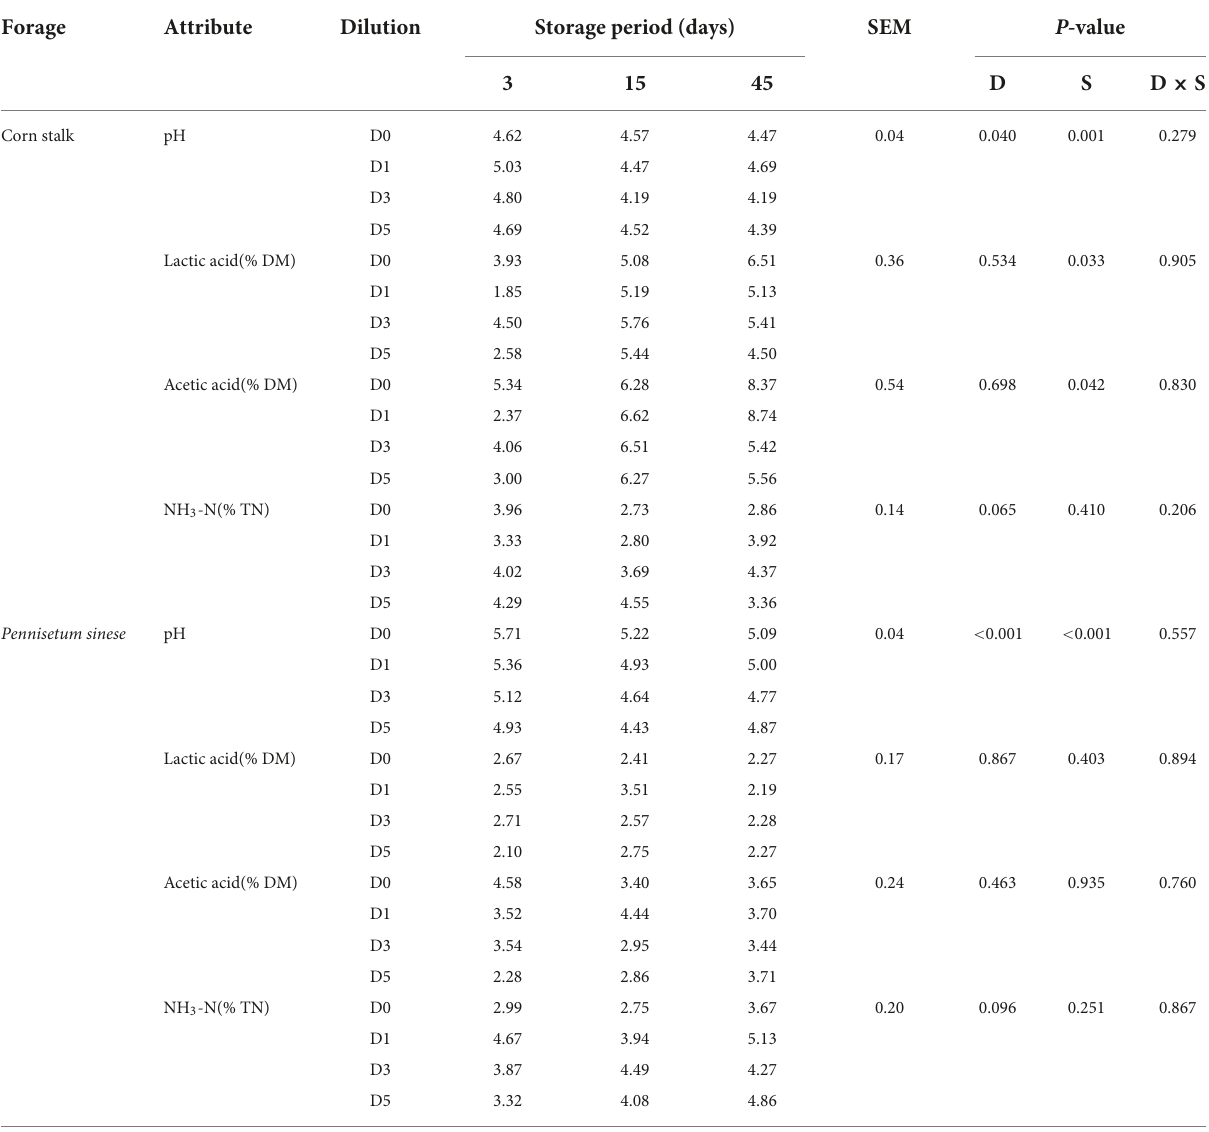
TABLE 1 Fermentative characteristics of corn stalk and Pennisetum sinese silages during ensiling.